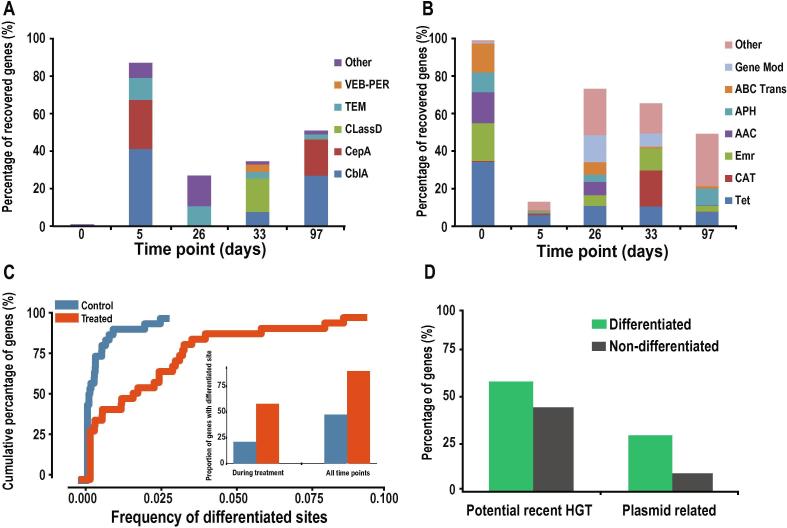
Variation of the gene abundance, differentiated sites, and HGT trend in the functional metagenomic ARGsA. Temporal variation of the gene abundance for functionally selected β-lactamases. B. Temporal variation of the gene abundance for functionally selected non-β-lactamase antibiotic resistance genes. C. Cumulative percentage of functional ARGs with different proportions of differentiated sites. The proportions of genes with differentiated sites before and during the treatment in both subjects are shown in the subfigure. D. Proportion of genes with recent HGT signatures and genes with plasmid mediated HGT in both differentiated and non-differentiated ARGs.